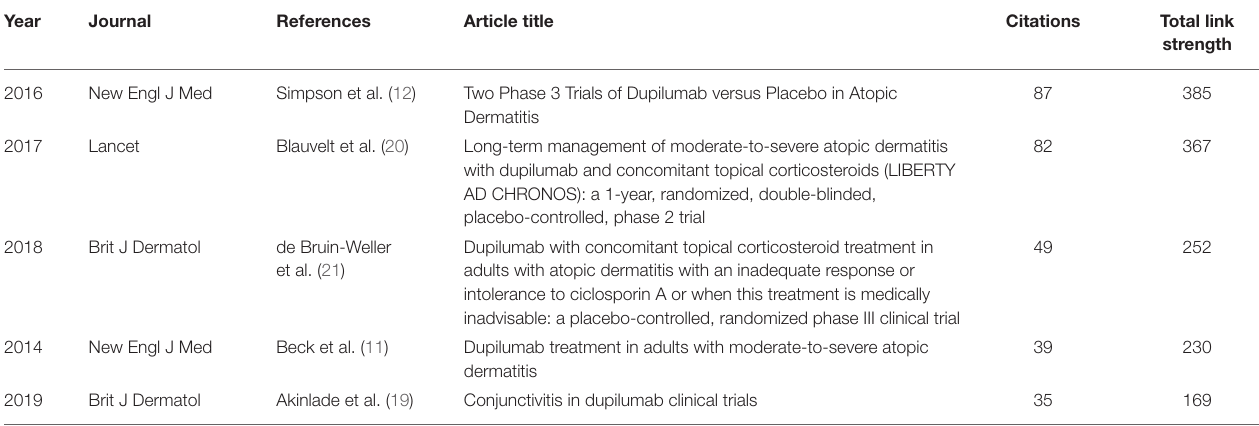
TABLE 2 | The top 5 articles in the analysis of reference